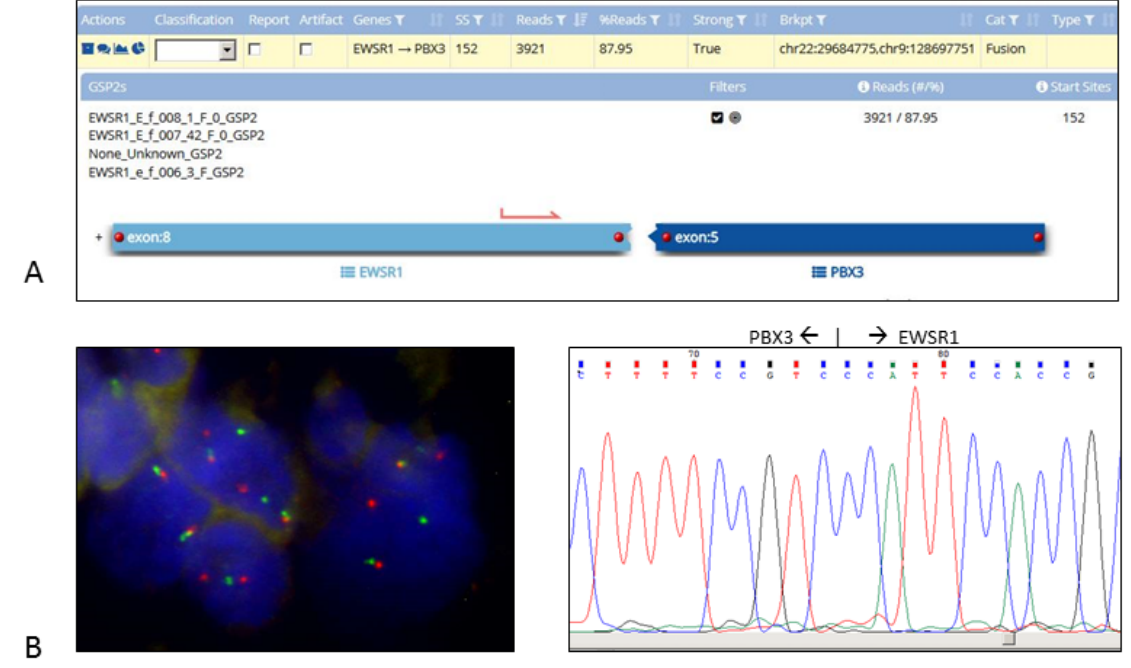
Figure 4. Identification of the EWSR1-PBX3 fusion transcript in case 5 (malignant myoepithelioma). ( A ) Analysis of anchored multiplex PCR result of the Archer FusionPlex Sarcoma Panel showed EWSR1-PBX3 fusion in the biopsy. ( B ) FISH of interphase nuclei using dual-colour break-apart probe for EWSR1 (22q12) gene reveals 1 non rearranged orange/green fusion signal, 1 separate orange signal and 1 separate green signal, indicating the translocation of EWSR1 in tumour cells. Original magnification: 140. ( C ) RT-PCR/Sanger sequencing revealed the sequence of the novel EWSR1-PBX3 fusion transcript. Partial sequence chromatogram showing the junction (arrow) of the PBX3 and EWSR1 genes.